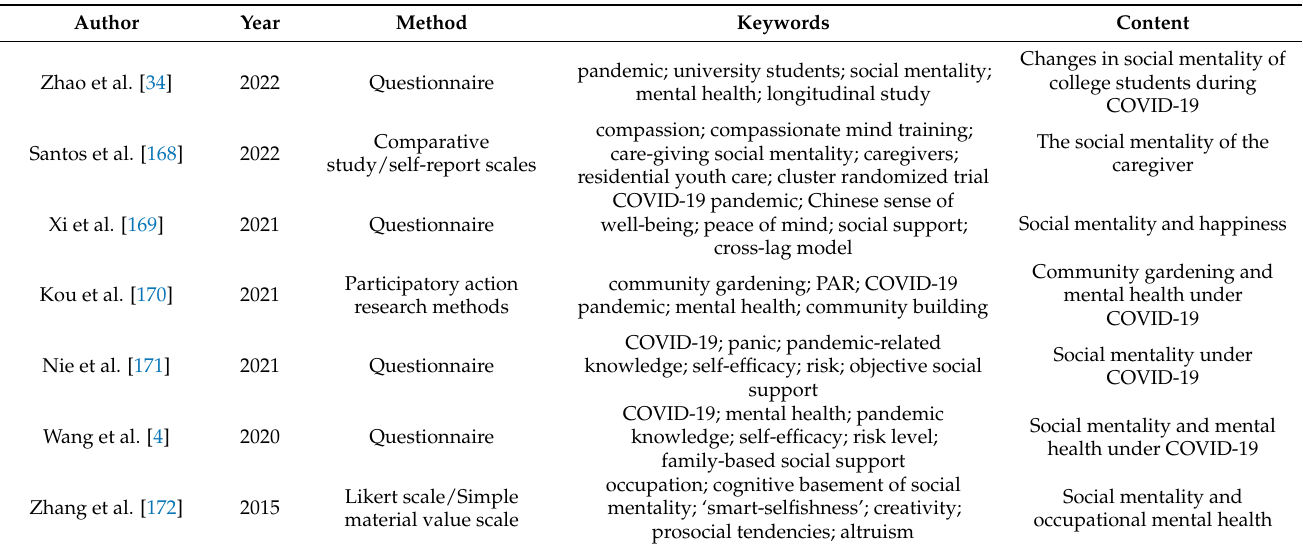
Table 5. Literature statistics of clusters on social mentality and health research in the WOS before 1 April 2022 (generated by the